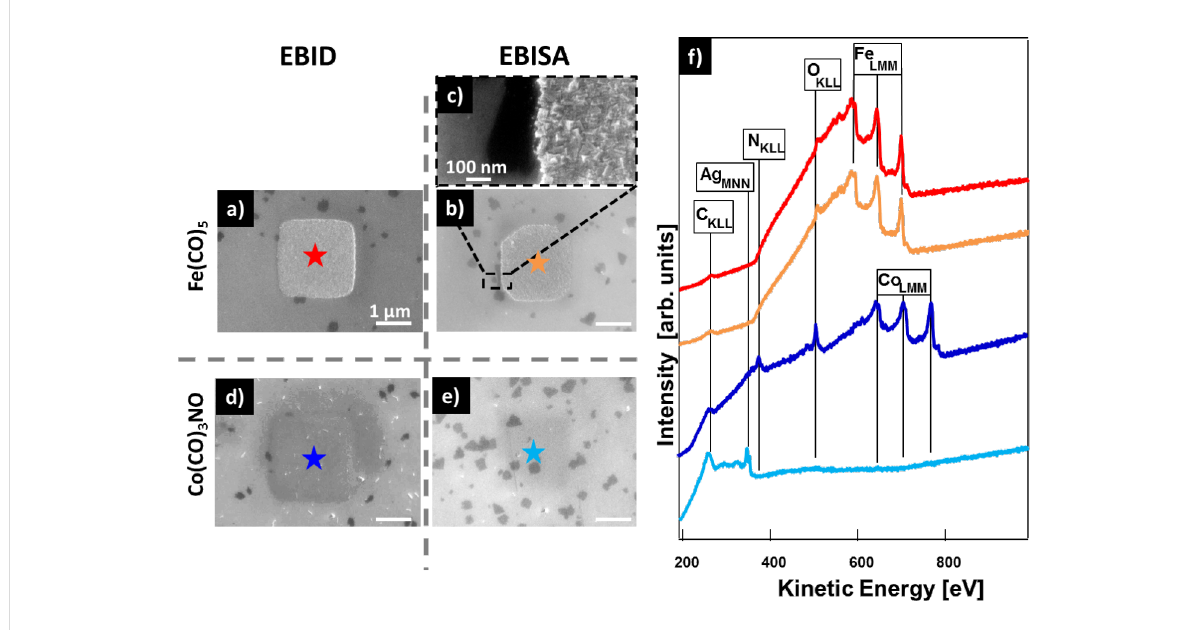
Figure 2: Results of FEBIP experiments followed by autocatalytic growth on a TPT SAM on Ag(111)/mica. All structures were written with E beam = 15 kV and I beam = 400 pA. (a) SEM image of a 2 × 2 µm 2 deposit fabricated via EBID + AG with Fe(CO) 5 (1.04 C/cm 2 and t AG = 3 h 44 min). (b) SEM image of a 2 × 2 µm 2 deposit fabricated via EBISA + AG with Fe(CO) 5 (7.80 C/cm 2 and t AG = 4 h 20 min). (c) SEM Blowup image of the structure from (b). (d) SEM image of a 2 × 2 µm 2 deposit fabricated via EBID + AG with Co(CO) 3 NO (4.68 C/cm 2 and t AG = 3 h 42 min). (e) SEM image of a 2 × 2 µm 2 deposit fabricated via EBISA + AG with Co(CO) 3 NO (7.80 C/cm 2 and t AG = 4 h 3 min). (f) Local AE spectra recorded at the positions indi- cated with correspondingly colored